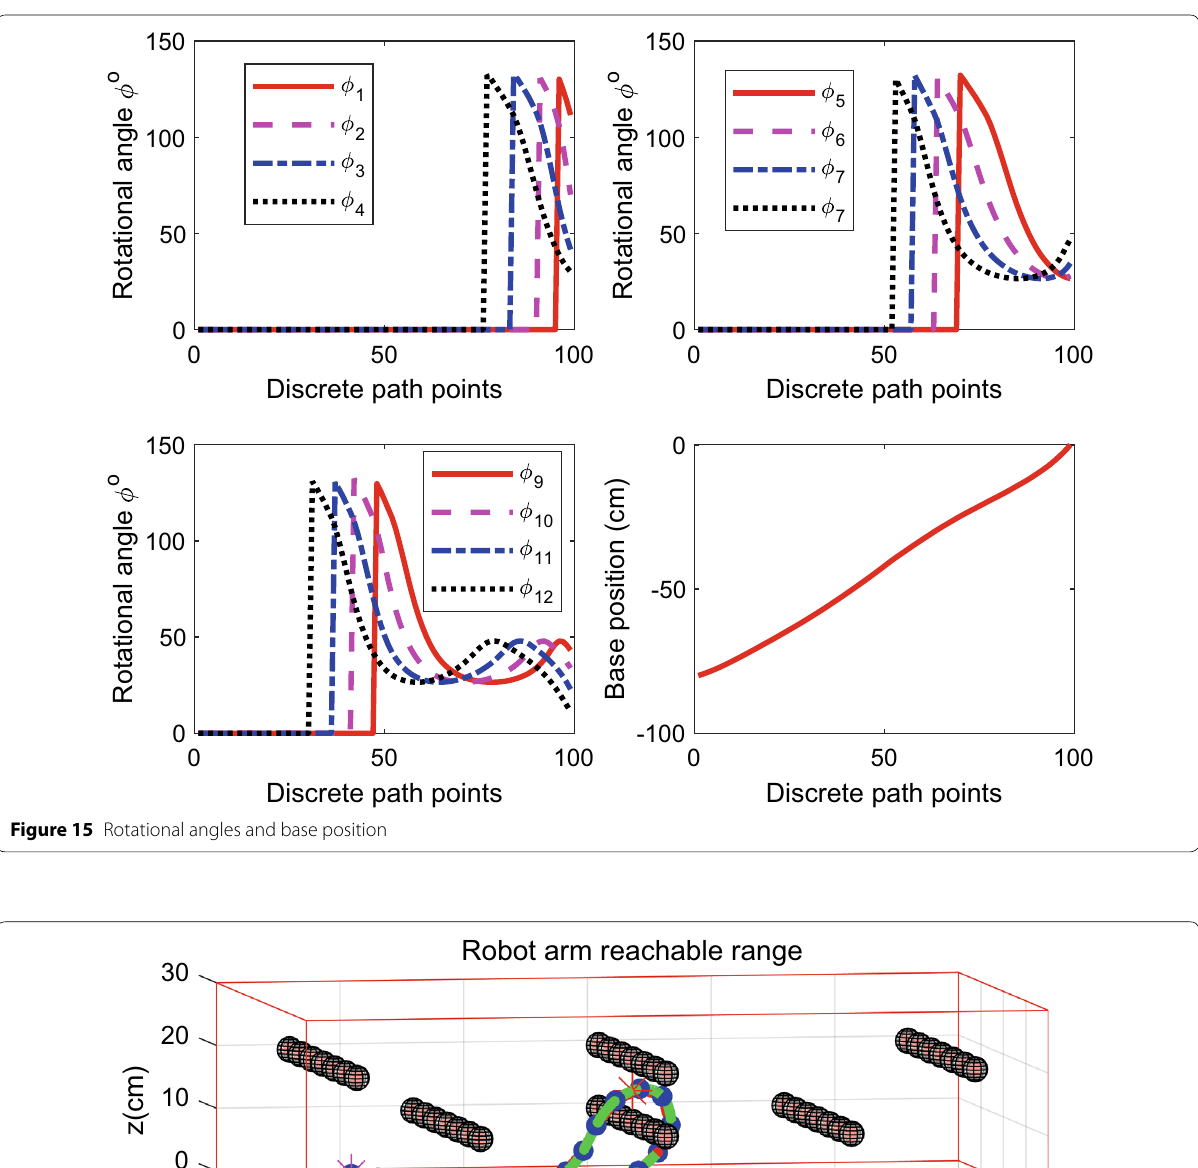
Figure 16 Robot manipulator tracking